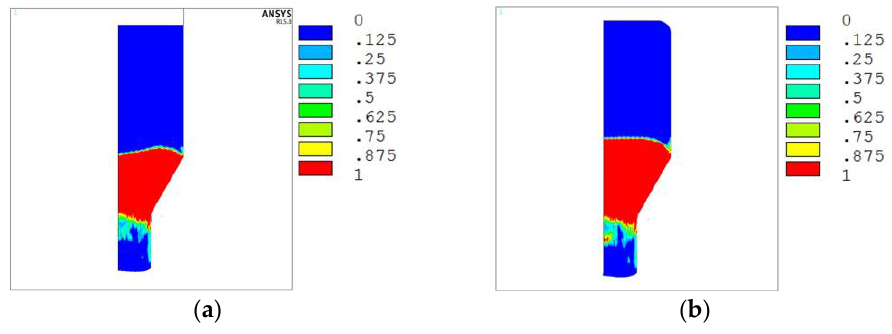
Figure 7. Stress state ratio distribution of ( a ) displacement load ( b ) and pressure load.